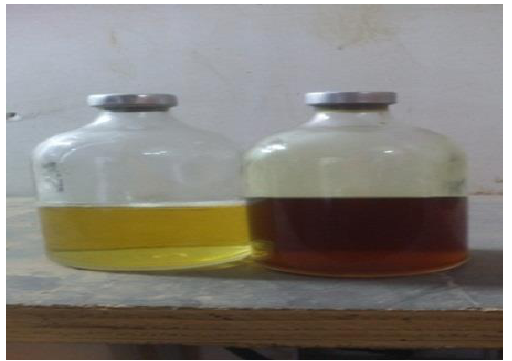
Figure,1: Changing in color after the reduction of Ag+ to SNPs by Salvia officinal's plant leafs extract at